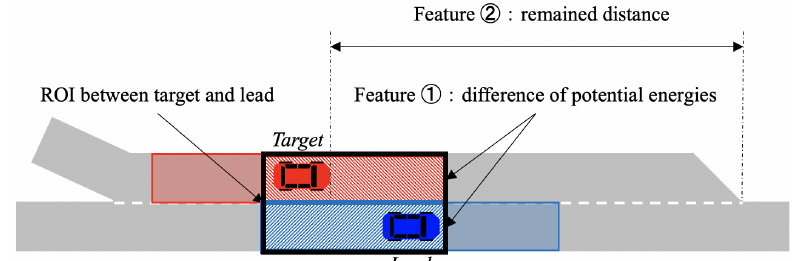
Figure 7. Definition of the proposed features: the proposed method uses two features for the goal estimation. The first feature is the difference of potential energies of the two lanes within the ROI. The second feature is the remained distance of the acceleration